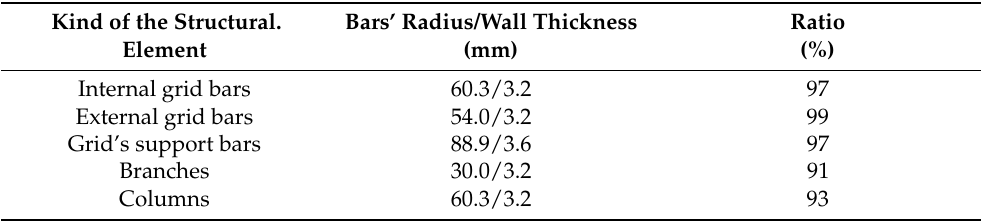
Table A3. Structural analysis results of structure 1b performed by Robot Structural Analysis Profes- sional software. Kind of the Structural.